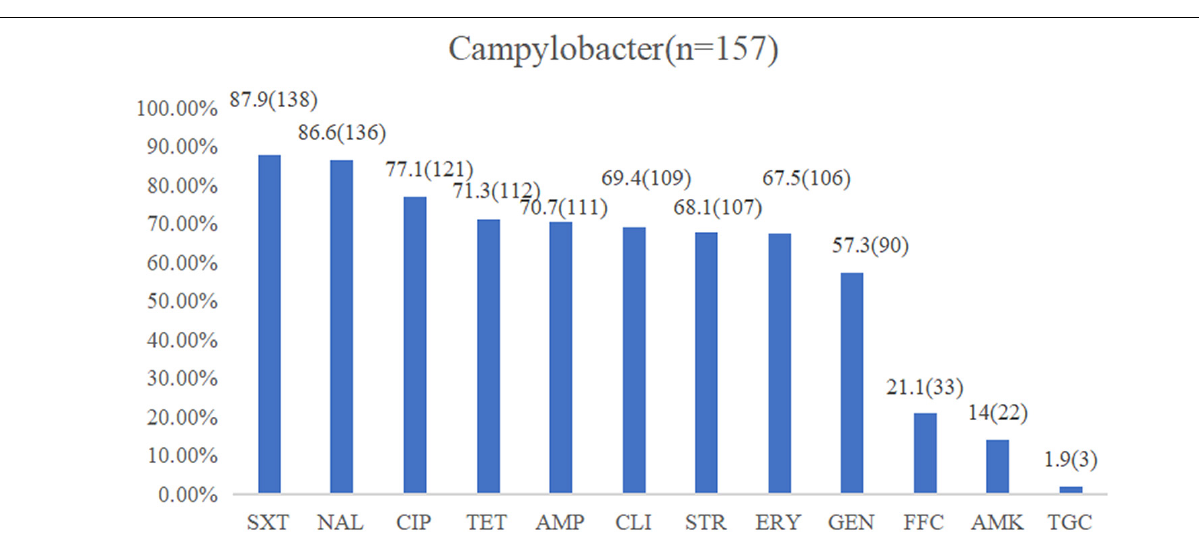
FIGURE 2 | Resistance proportions of Campylobacter spp. from the yellow-feathered broiler slaughterhouse against 12 antibiotics. Abbreviations for antimicrobial agents: SXT, sulfamethoxazole; NAL, nalidixic acid; CIP, ciprofloxacin; TET, tetracycline; AMP, ampicillin; CLI, clindamycin; STR, streptomycin; ERY, erythromycin; GEN, gentamicin; FFC, florfenicol; AMK, amikacin; TGC,